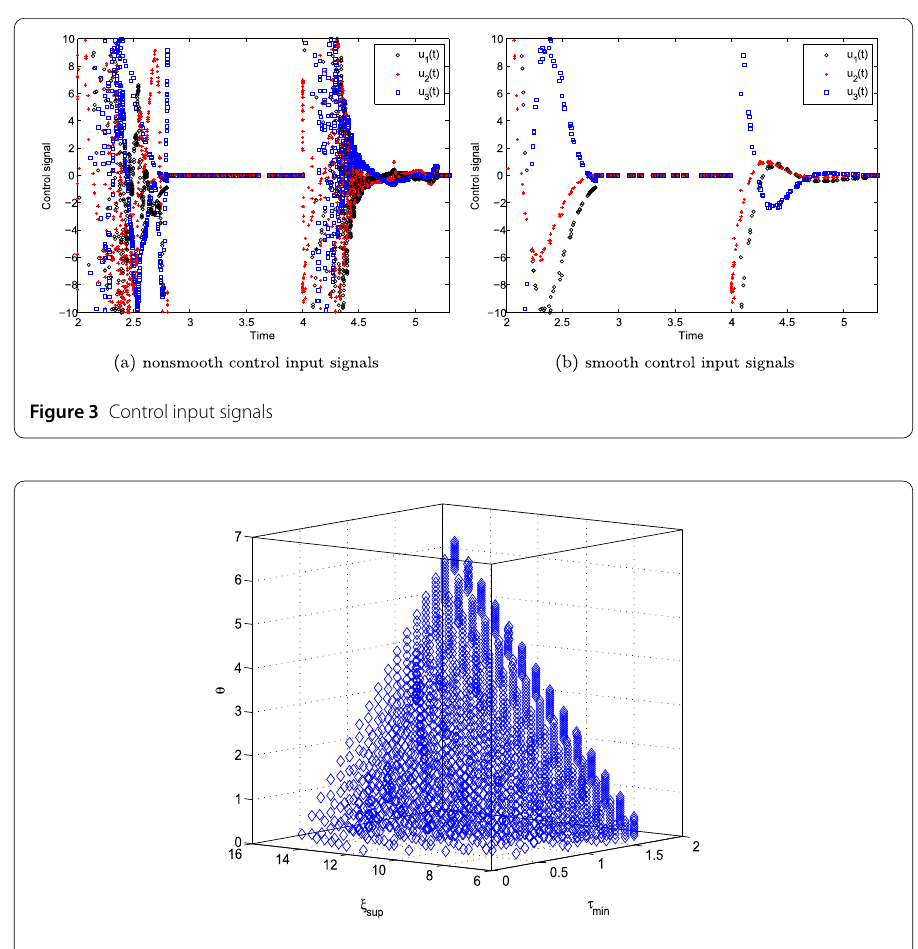
Figure 4 An illustration for the relationship between the supremum of smooth index function set ξ sup , the minimum admissible control width τ min and the exponential rate